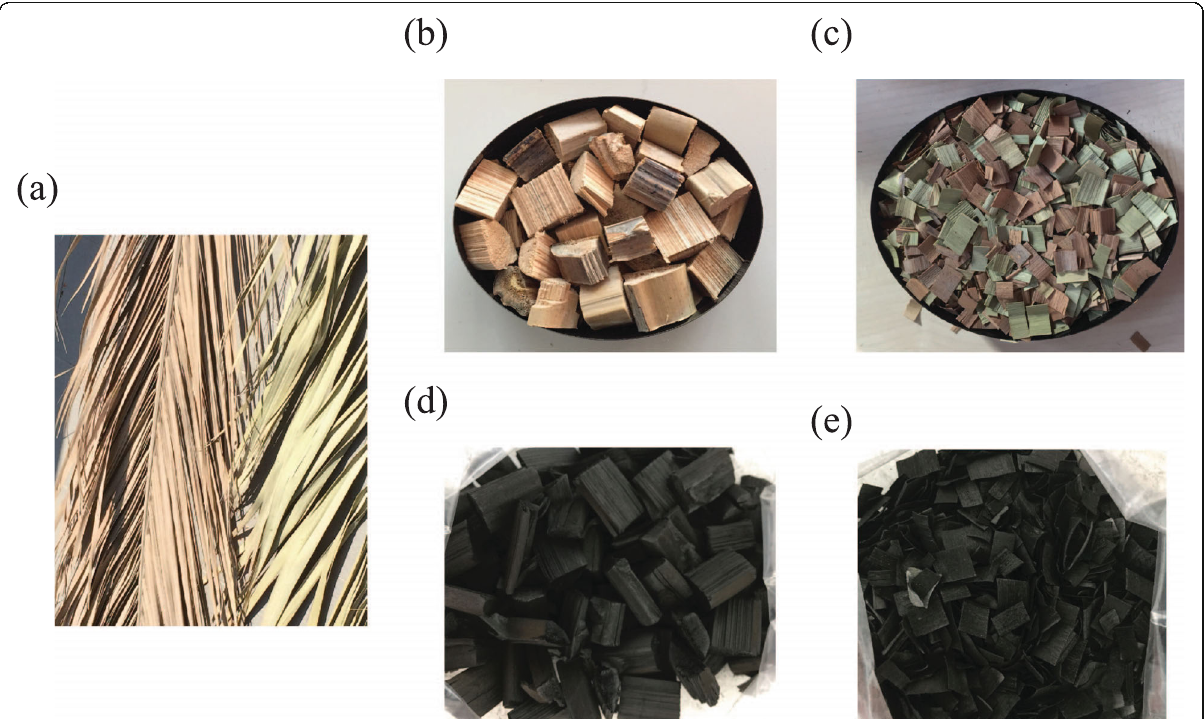
Fig. 1 a Collected date palm waste, b frond feedstock, c leaf feedstock, d frond biochar, e leaf